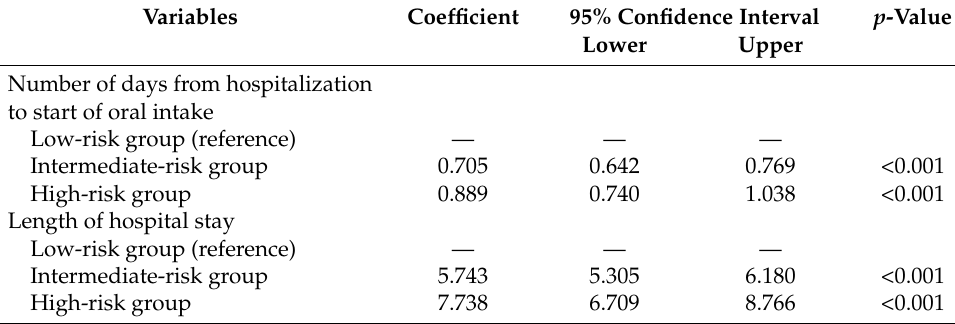
Table 3. Multiple linear regression analysis for primary